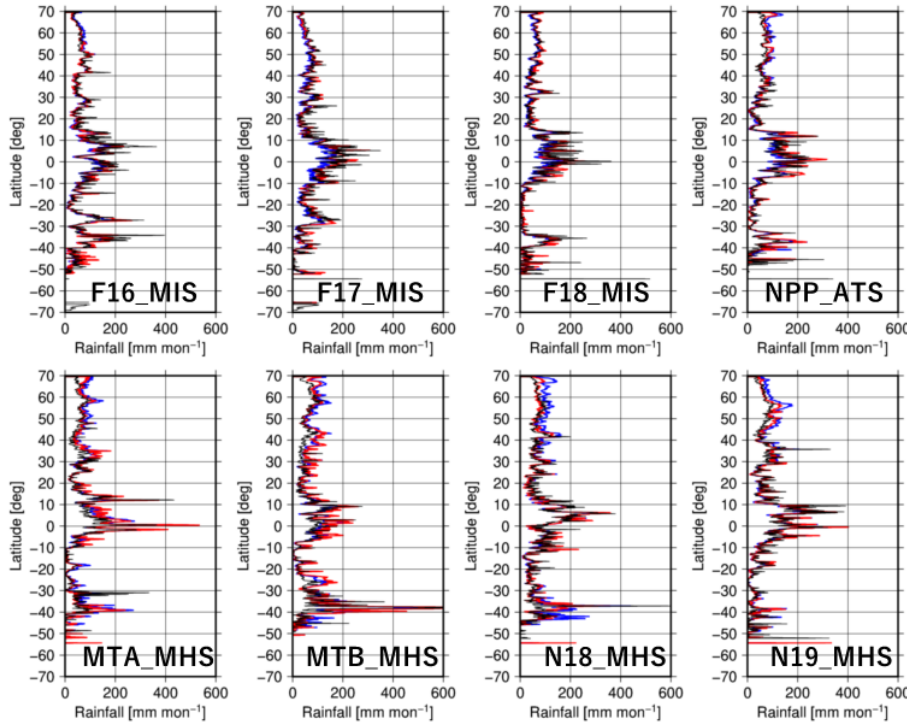
Figure 5. The same as Figure 4 except for over land.